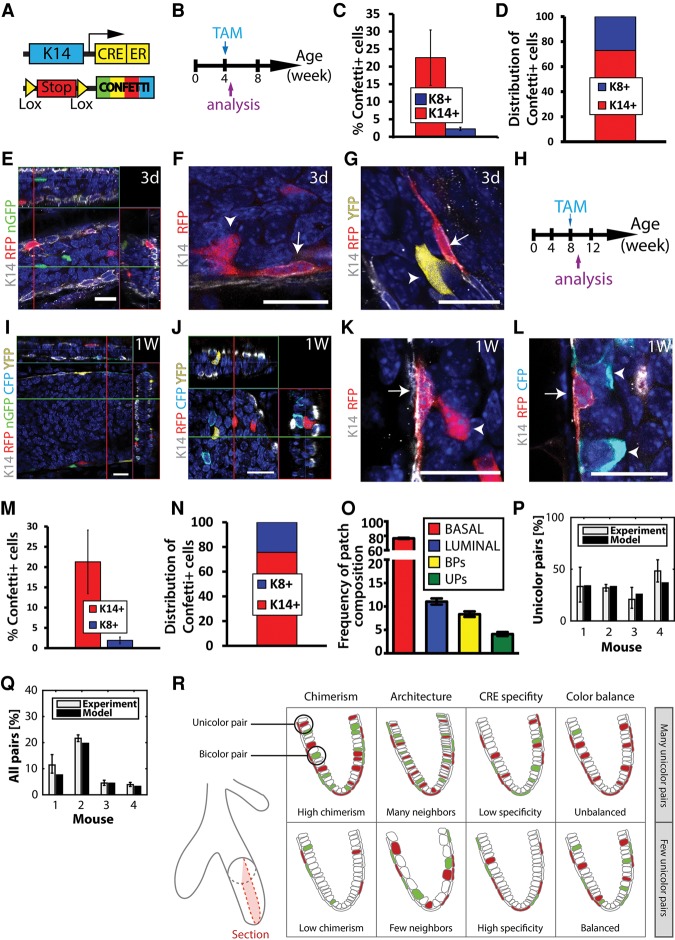
K14CreERT2 targets initially and independently unipotent BCs and LCs in the MG. (A) Scheme summarizing the genetic strategy used to target Confetti expression in K14-expressing cells. (B) Scheme summarizing the protocol used to study the fate of cells targeted at puberty using K14CreERT2/Rosa-Confetti mice. (C,D) Percentage of Confetti+ cells in basal K14+ and luminal K8+ cells (C) and distribution of basal K14+ and luminal K8+ cells among Confetti+ cells (D) 3 d after TAM injection (1.5 mg) at puberty in K14CreERT2/Rosa-Confetti mice (15524 cells out of three mice). (E–G) Confocal imaging of immunostaining of K14 and Confetti 3 d after TAM administration (1.5 mg) at puberty in K14CreERT2/Rosa-Confetti mice. Examples of independently and initially labeled BCs and LCs (E), UPs (F), and BPs (G) containing BCs and LCs. (H) Scheme summarizing the protocol used to study the fate of cells targeted in adulthood using K14CreERT2/Rosa-Confetti mice. (I–L) Confocal imaging of immunostaining of K14 and Confetti at 1 wk after TAM administration (1.5 mg) to K14CreERT2/Rosa-Confetti adult virgin mice. Examples of independently and initially labeled BCs (I) and LCs (J) as well as UPs (K) and BPs (L) containing BCs and LCs. (M,N) Percentage of Confetti+ cells in basal K14+ and luminal K8+ cells (M) and distribution of K14+ BCs and K8+ LCs among Confetti+ cells (N) 1 wk after TAM injection (1.5 mg) to K14CreERT2/Rosa-Confetti adult virgin mice (55287 cells out of five mice). (O) Frequency of Confetti+ patch compositions 1 wk after TAM injection (1.5 mg) to K14CreERT2/Rosa-Confetti adult virgin mice. (P) Fraction of UPs among all pairs 1 wk after TAM injection (1.5 mg) to K14CreERT2/Rosa-Confetti adult virgin mice. Experimental bars (gray) represent the number of UPs divided by the total number of pairs. Model bars (black) represent the prediction of the fraction of UPs among all pairs, which depends only on the relative frequencies of the Confetti colors. (Q) Fraction of total pairs 1 wk after TAM injection (1.5 mg) to K14CreERT2/Rosa-Confetti adult virgin mice. Experimental bars (gray) represent the total number of pairs divided by the total number of labeled BCs. Model bars (black) represent the prediction of the overall fraction of pairs, which is based on the probability of random labeling of BCs. Although a formal expression is derived in the Supplemental Material, this fraction is roughly proportional to three factors: the degree of chimerism, the specificity of the CRE, and the architecture of the tissue (i.e., how many LCs touch a BC). (R) Scheme summarizing the parameters taken into account in the model. In a hypothetical situation with only two colors, variation of any of these parameters influences the observed number of UPs. Arrows depict BCs, and arrowheads depict LCs. (E,I,J) Orthogonal projections of 3D stack. (F,G,K,L) Single-plane images from a 3D stack. Bars, 20 µm. Error bars represent mean ± SEM, except in O, where it represents one-σ binomial confidence levels for the observed frequencies of patch compositions, and in P and Q, where it represents standard deviation. See Supplemental Table S3 for further information on the statistics.